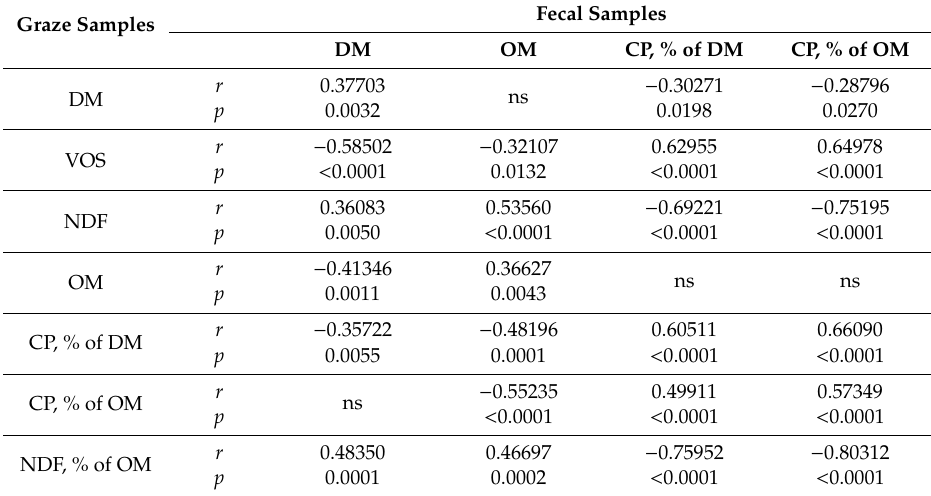
Table 7. Correlation coe ffi cient ( r , p -value) between nutrient concentrations in graze samples and in fecal samples from 12 Gotlandsruss kept in three enclosures between May 2014 and September 2016 without supplementary feeding. DM = dry matter, OM = organic matter, CP = crude protein, VOS = digestibility coe ffi cient of organic matter, NDF = neutral detergent fiber. Graze Samples